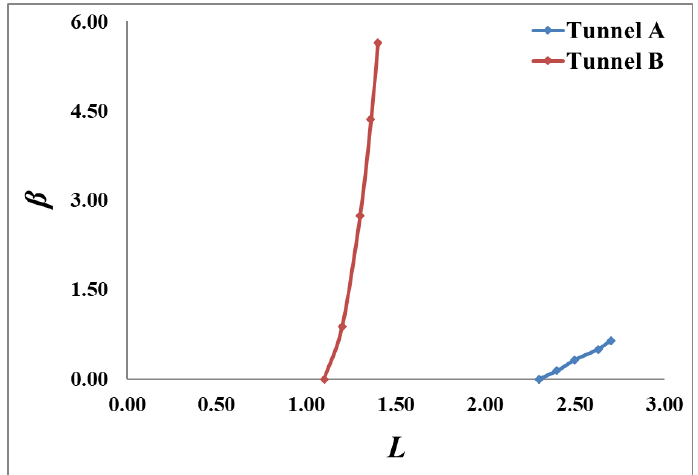
Figure 6. Reliability index results with the variation of the resistance L , regarding unsupported tunnels A and B ( i 0 P =